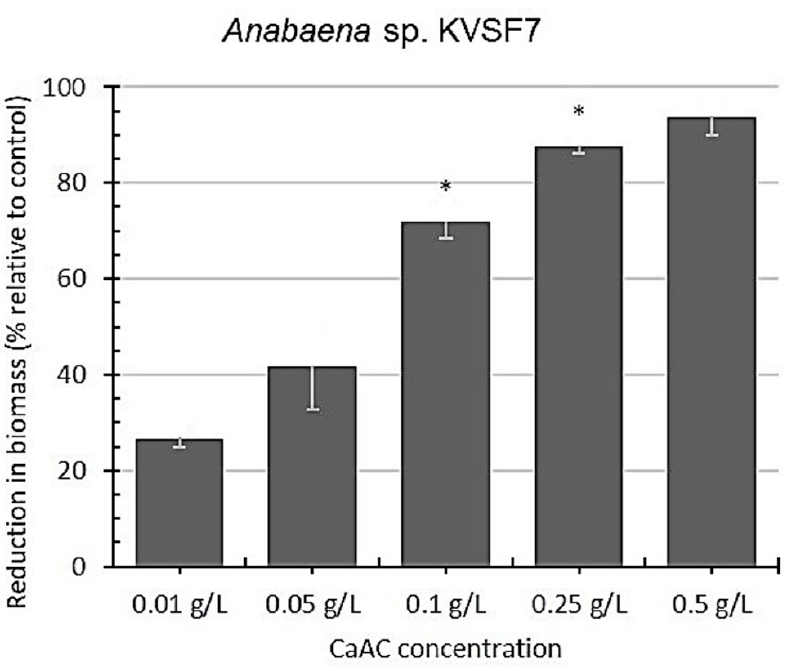
Figure 5. Reduction in biomass of A.S. culture in Microcystis cell-free medium containing different dosages of CaAC (0.01, 0.05, 0.1, 0.25, and 0.5 g/L). The standard deviations of the mean ( n = 3) are represented by the error bars. A p < 0.05 value is considered to represent significant difference. The “*” sign is applied for this significant